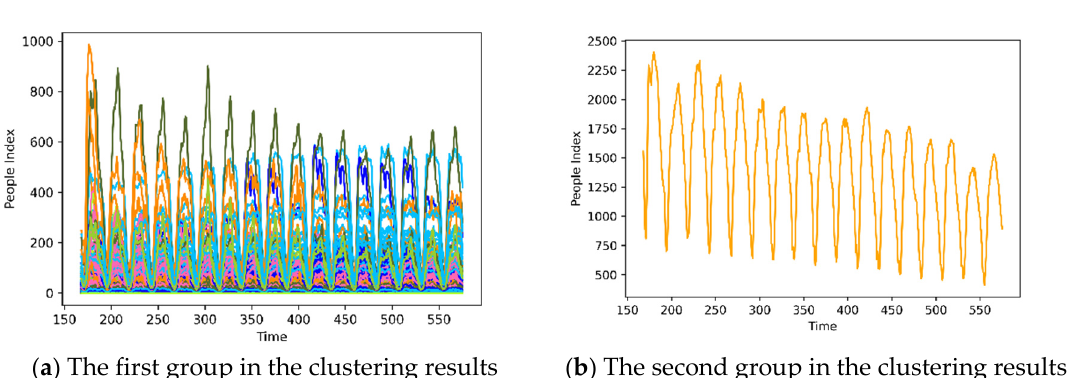
Figure 9. Clustering results of two patterns of changes in pedestrian flow at hotspot locations in Beijing during the epi- demic.